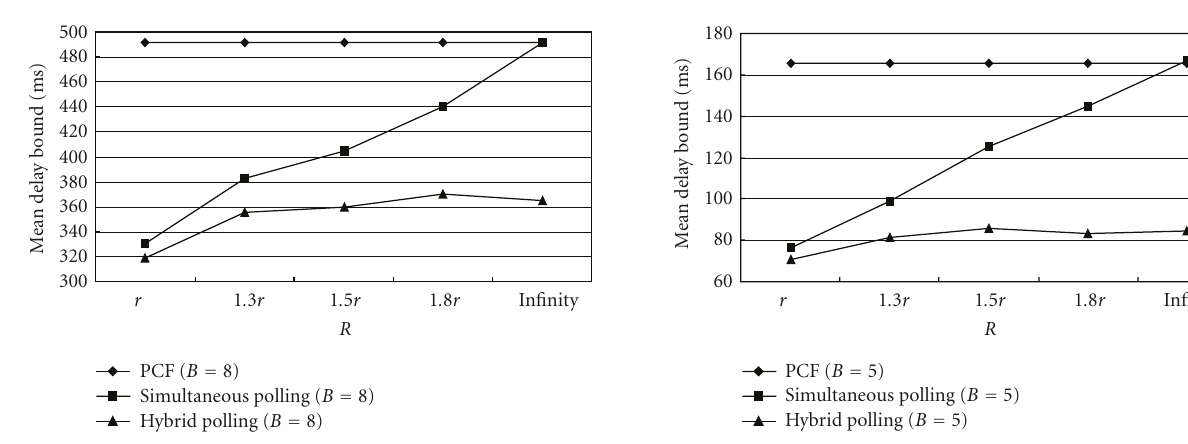
Figure 9: Mean delay bounds when the heavy tra ffi c load ( B = 8) is imposed on IEEE 802.11a wireless LAN with 30 STAs.